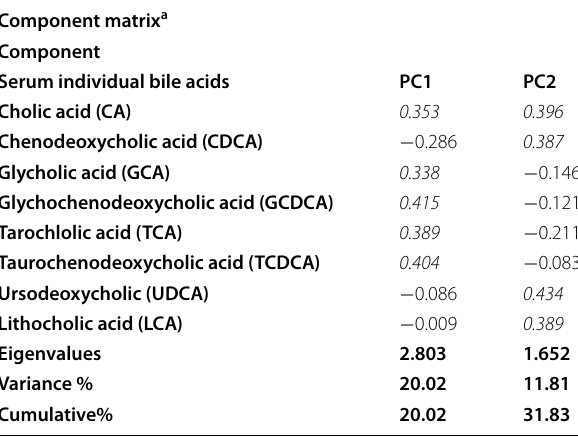
Table 8 Component matrix of PC1 and PC2